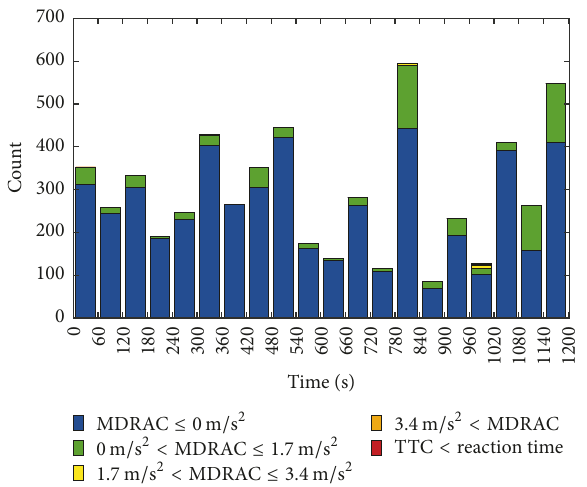
Figure 13: DCIA values calculated with PRT = 2.02 s categorized in four groups over the considered time interval in lane